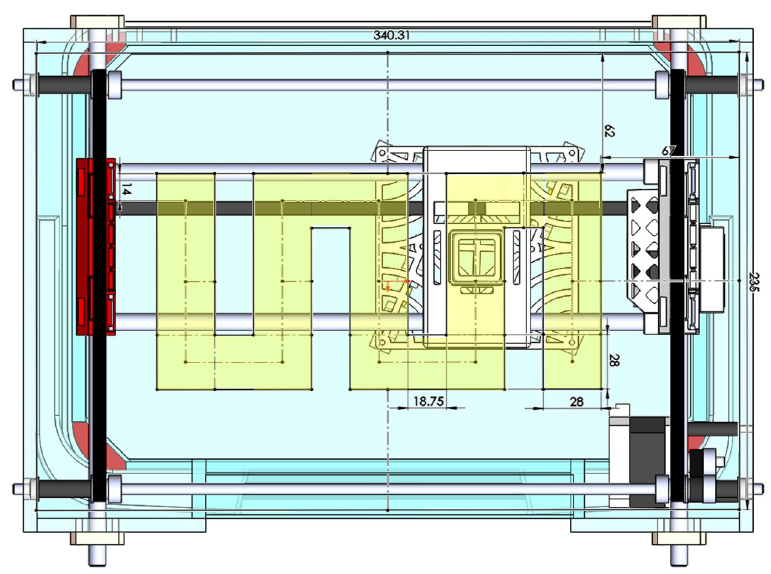
Figure 7. Schematic of the forward path the antenna set follows over the breast (the system top view, dimensions are in